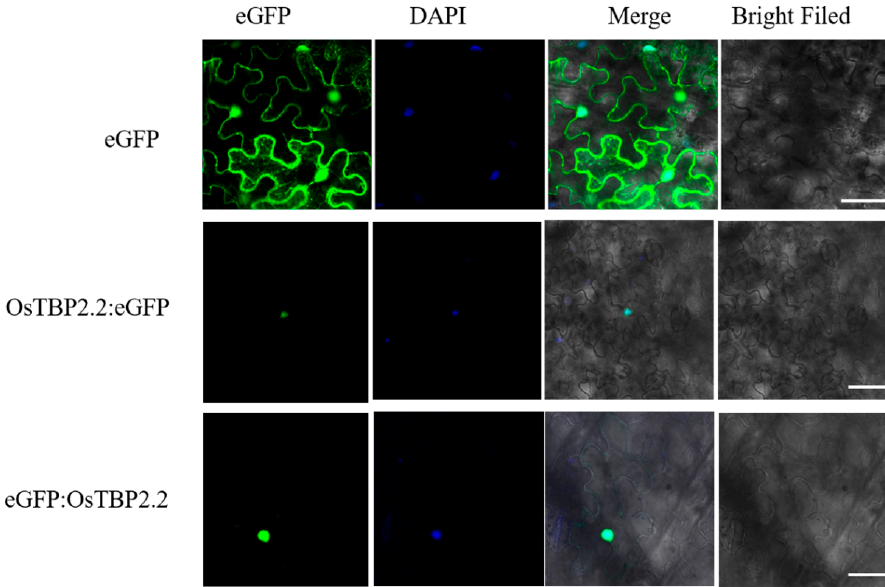
Figure 2. Subcellular localization of OsTBP2.2 Tobacco ( N. benthamiana ) leaves were transiently transformed by Agrobacterium tumefaciens harboring plasmid expressing OsTBP2.2::GFP and GFP::OsTBP2.2 fusion protein . Images were taken under a confocal laser scanning microscope in dark field for green fluorescence. Dark cultivation for three days in a growth room, 14 h 30 °C/10 h 22 °C and 60% relative humidity. DAPI (4'6-diamidino-2-phenylindole) staining was used to mark the nucleus. Bars = 5 µm .